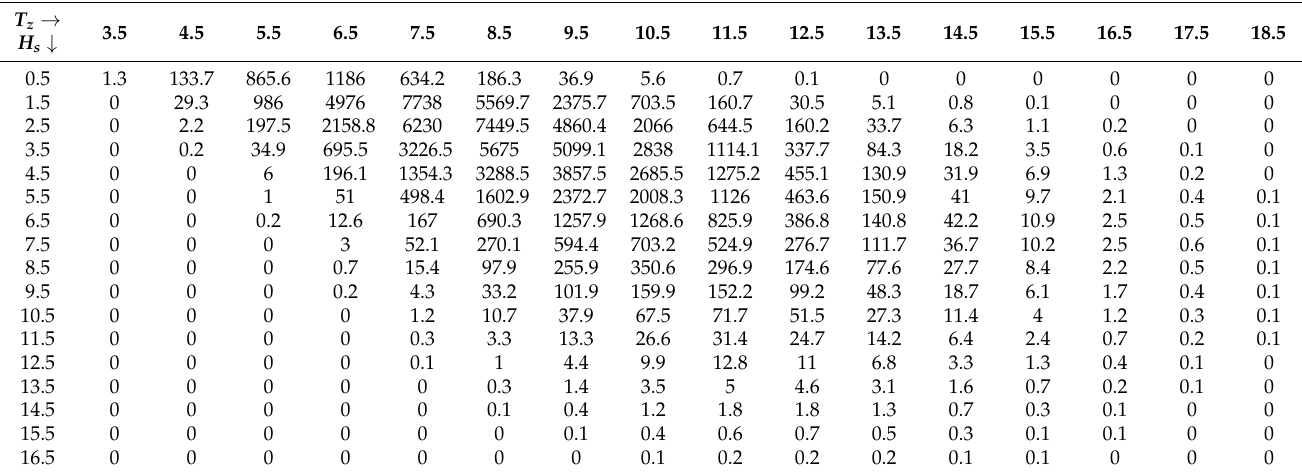
Table 3. Wave case occurrences [12].